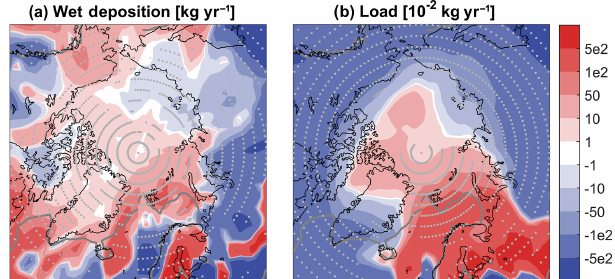
Figure 7. Total winter (DJF) trends (1980–2015) of maximum like- lihood estimates (MLEs) of BC wet deposition (kgyr − 1 ) and load (kg × 10 − 2 yr − 1 ) associated with three atmospheric circulation pat- terns (Total = IC NAO + IC SB + IC ENSO ) . The grey line represents the mean winter sea ice and snow cover larger than 50% from 1980 to now. Grey dots represent the grid points with trend significant at 5%